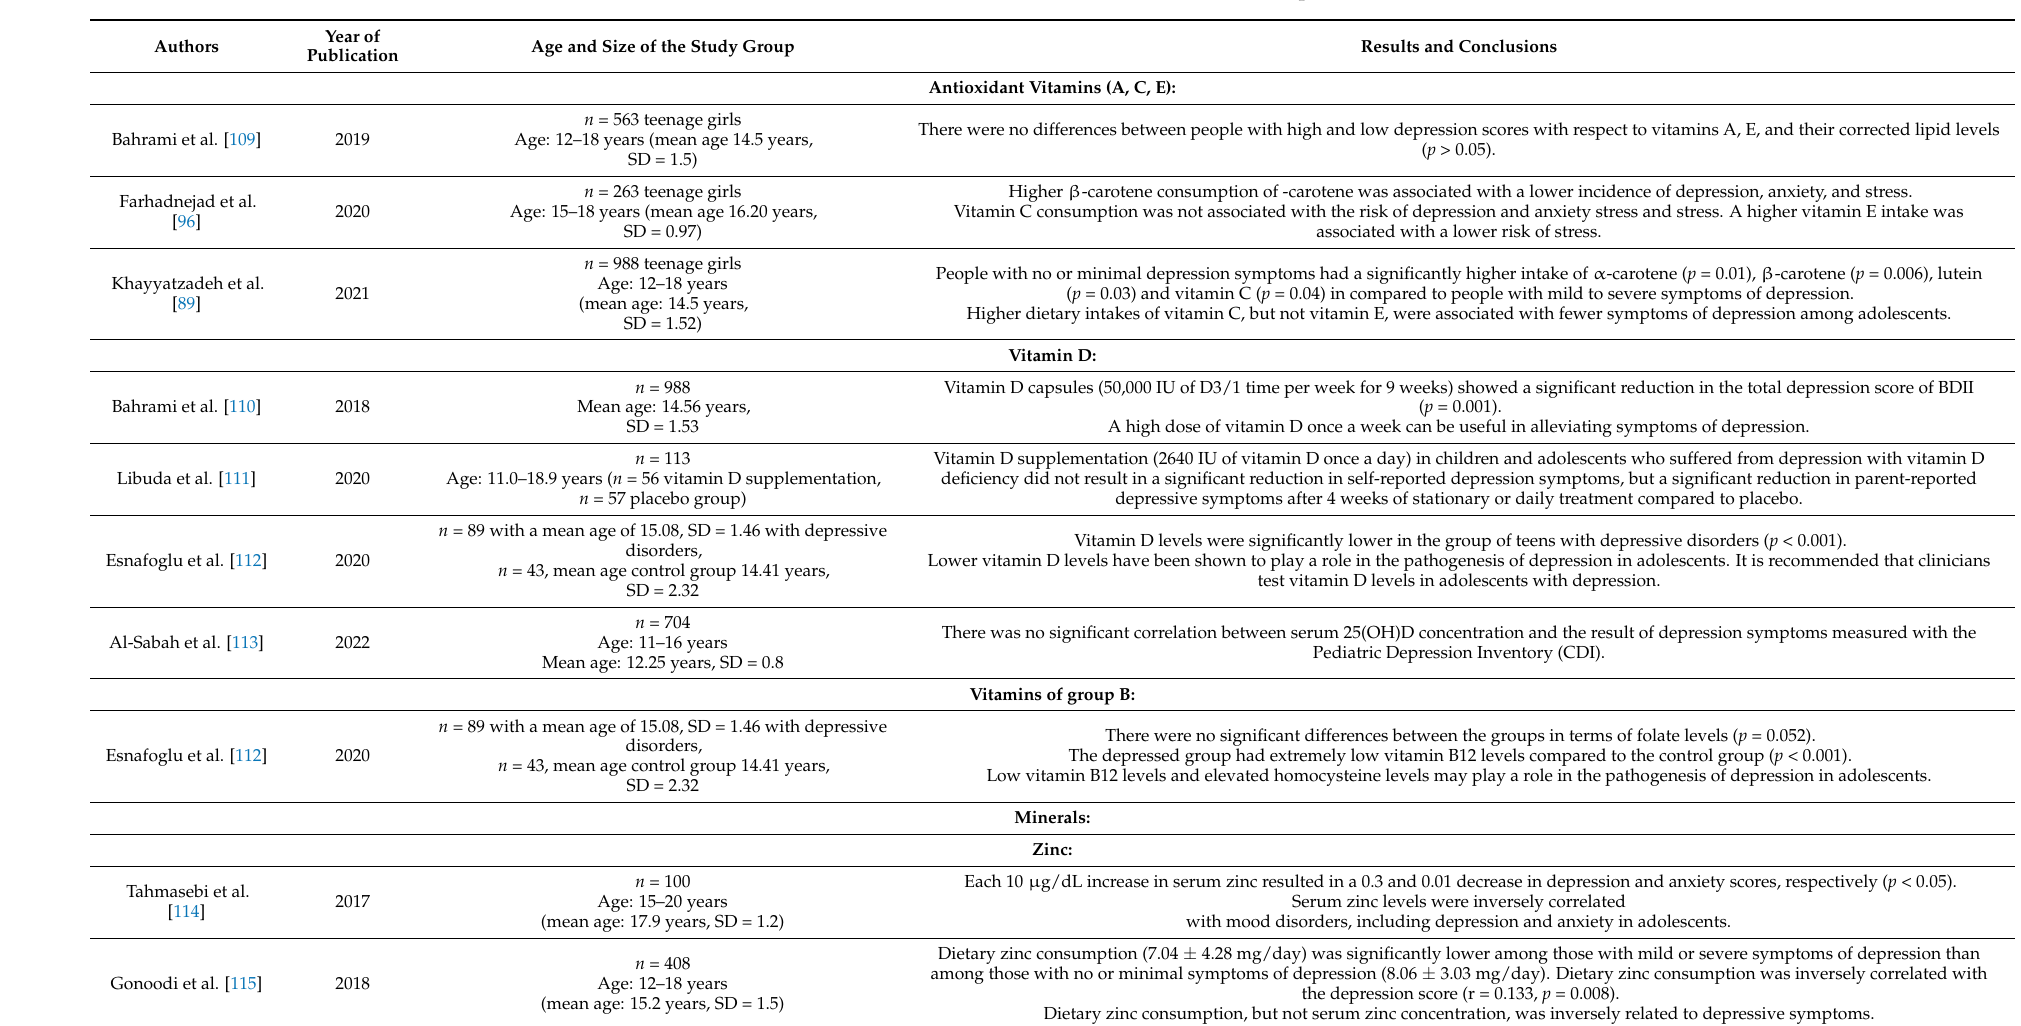
Table 4. Vitamins and minerals in the diet of children and adolescents with adolescent